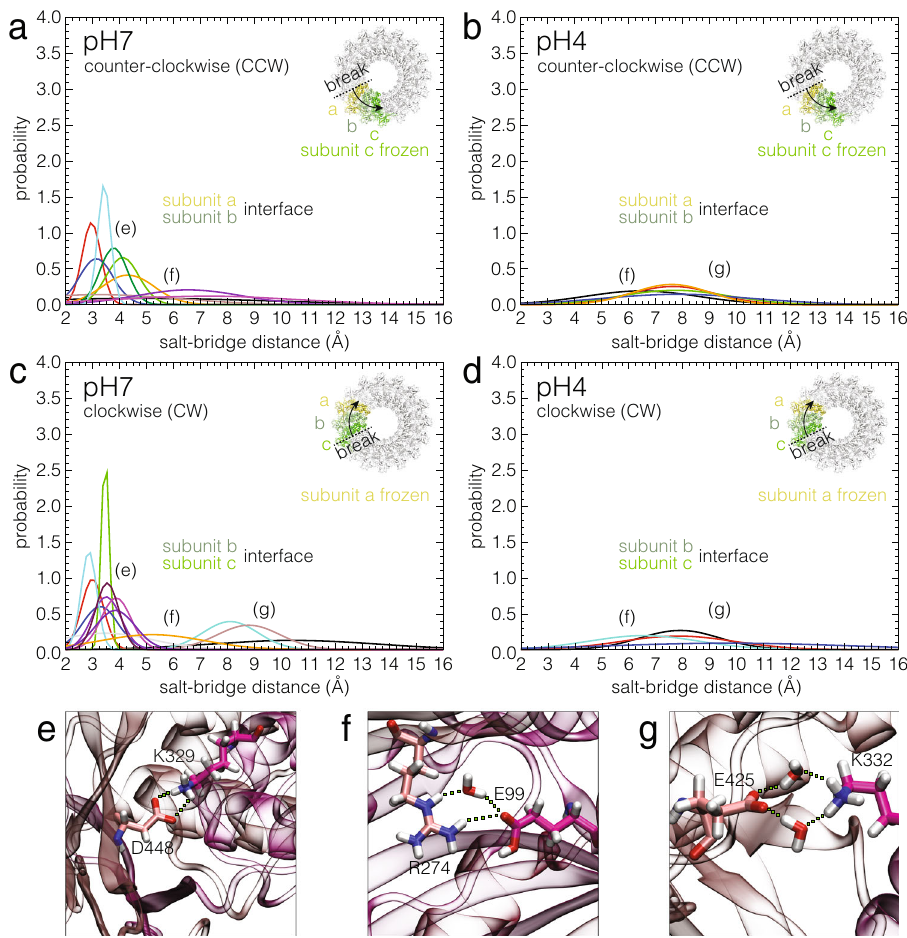
Fig. 4 | Inter-subunit salt bridges are pH sensitive. Comparison of the prob- abilitiesofoccurrenceofinterfacialsaltbridgesatneutral( a , c )andacidic( b , d )pH inferred from µ s-timescale molecular dynamics trajectories, between the fi rst and second subunit in CCW (subunit a-b interface, subunit c frozen) or in CW (subunit b-c interface, subunit a frozen) direction. Each line represents an individual salt bridge. The salt bridges are labeled with ( e , f , g ) according to their carboxylate